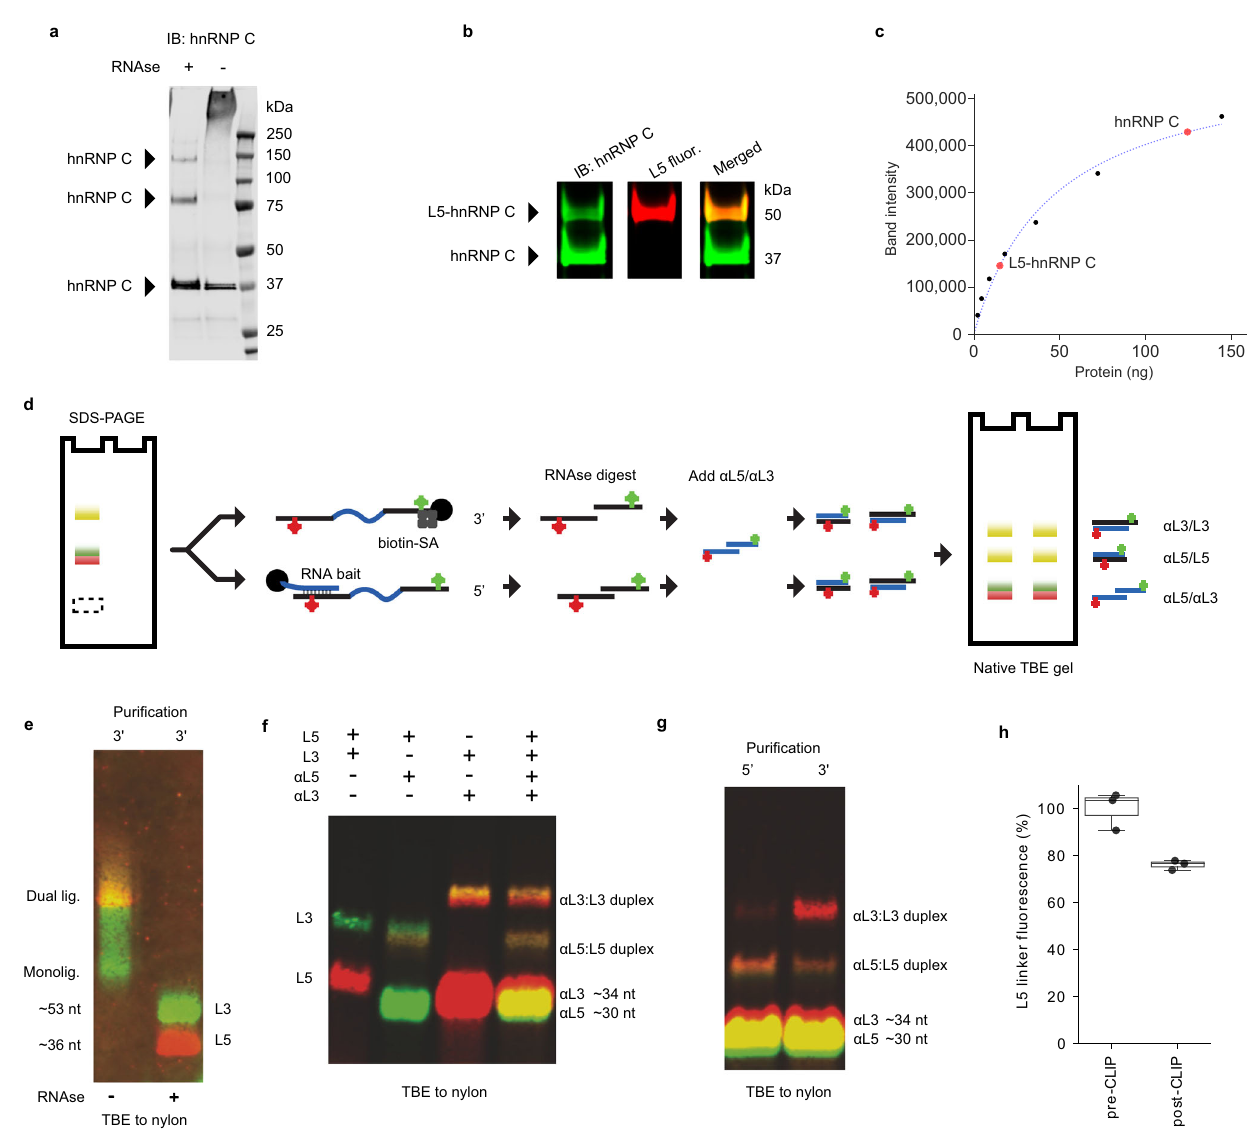
Fig. 3 A method to quantify the absolute number of ligated RNA – protein complexes. a Fraction of hnRNP C UV cross-linked to RNA, including hnRNP C that cannot be collapsed to a monomeric band by RNAse. The experiment was performed twice with similar results. b Ligation of the L5 adapter creates a novel band of monomeric hnRNP C-RNA-L5. The experiment was performed three times with similar results. c Absolute quanti fi cation of the monomeric hnRNP C and L5-hnRNP C band using a standard curve of GST-hnRNP C quantifying the number of L5 molecules in the complex and thereby fl uorescence per molecule. Black dots comprise the standard curve and red dots endogenous hnRNP C. d Schematic of the method to estimate the amount of fl uorescence per L5 molecule lost in the CLIP procedure. e RNA puri fi ed as in d may be RNAse treated to collapse signal into adapter bands. The sizes of oligos are approximated with the dye molecule counting as 6 nt. The experiment was performed once. f The method in d applied to known amounts of free L5 and L3 adapter; note that adapters are completely shifted. The experiment was performed three times with similar results. g Application of the method in d to visualize fl uorescence of hnRNP C-cross-linked RNA after a CLIP procedure. Visualization was performed once, not including the quanti fi ed samples below. h Fluorescence loss of L5 from the CLIP procedure in replicate experiments ( n = 3). The box limits denote the 25 – 75% quartile range, the center line is the median, and whiskers show extreme 100% of L5 and L3 adapters were shifted (Fig. 3f) and the method By quantifying the amount of fl uorescence signal in the single- and was applied to RNAse-digested CLIP oligonucleotides (Fig. 3g). dual-ligated protein – RNA complexes, ef fi ciency estimates can be By comparing the ratio of α L5 to L5 for fresh L5 vs L5 extracted obtained for both 5 ′ and 3 ′ (Fig. 4b, c). Based on the premise that from the nitrocellulose membrane in CLIP, the L5 fl uorescence the two ligations are independent events, the total amount of cross- loss from CLIP could be determined to consistently be only ~20% linked RNA was also obtained, including unlabelled RNA (Fig. 4c), (Fig. 3h). and L5 ligation ef fi ciencies estimated (Fig. 4d). Cross-linking molecule number were estimated by replicate (Supplementary Data 6). For a second method, RNA was extracted from nitro- Ligation ef fi ciency . Three methods were used to estimate easyCLIP cellulose using proteinase, puri fi ed using either L5 or L3, run on ligation ef fi ciency. First, both fl uorescent L5 and L3 adapters were a gel, and transferred to a nylon membrane. Higher molecular ligated and visualized as single vs dual adaptor size shifts (Fig. 4a).